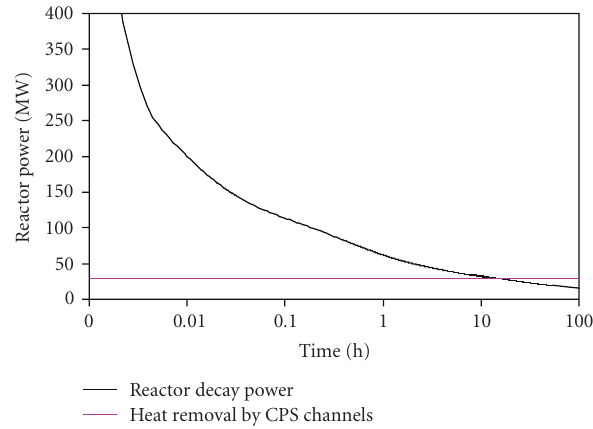
Figure 19: Comparison of reactor decay heat with capacity of heat removal from core by CPS cooling circuit (when regular CPS cooling system is